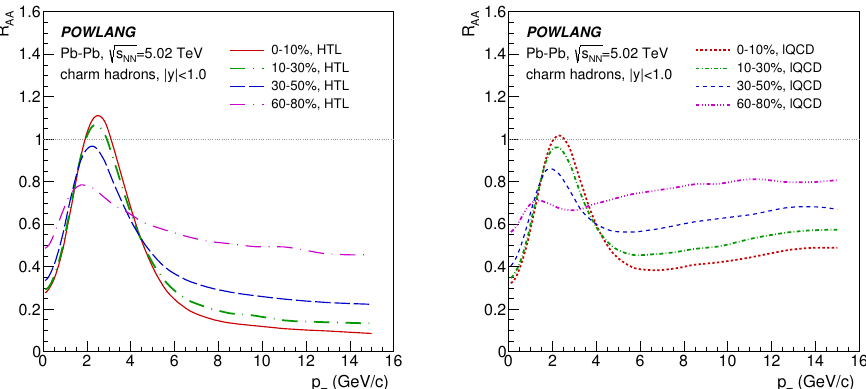
Figure 14 . POWLANG results with weak-coupling (left panel) and l-QCD (right panel) transport coe(cid:14)cients for the nuclear modi(cid:12)cation factor of charm hadron spectra in Pb-Pb collisions at p s NN =5 : 02 TeV for various centrality